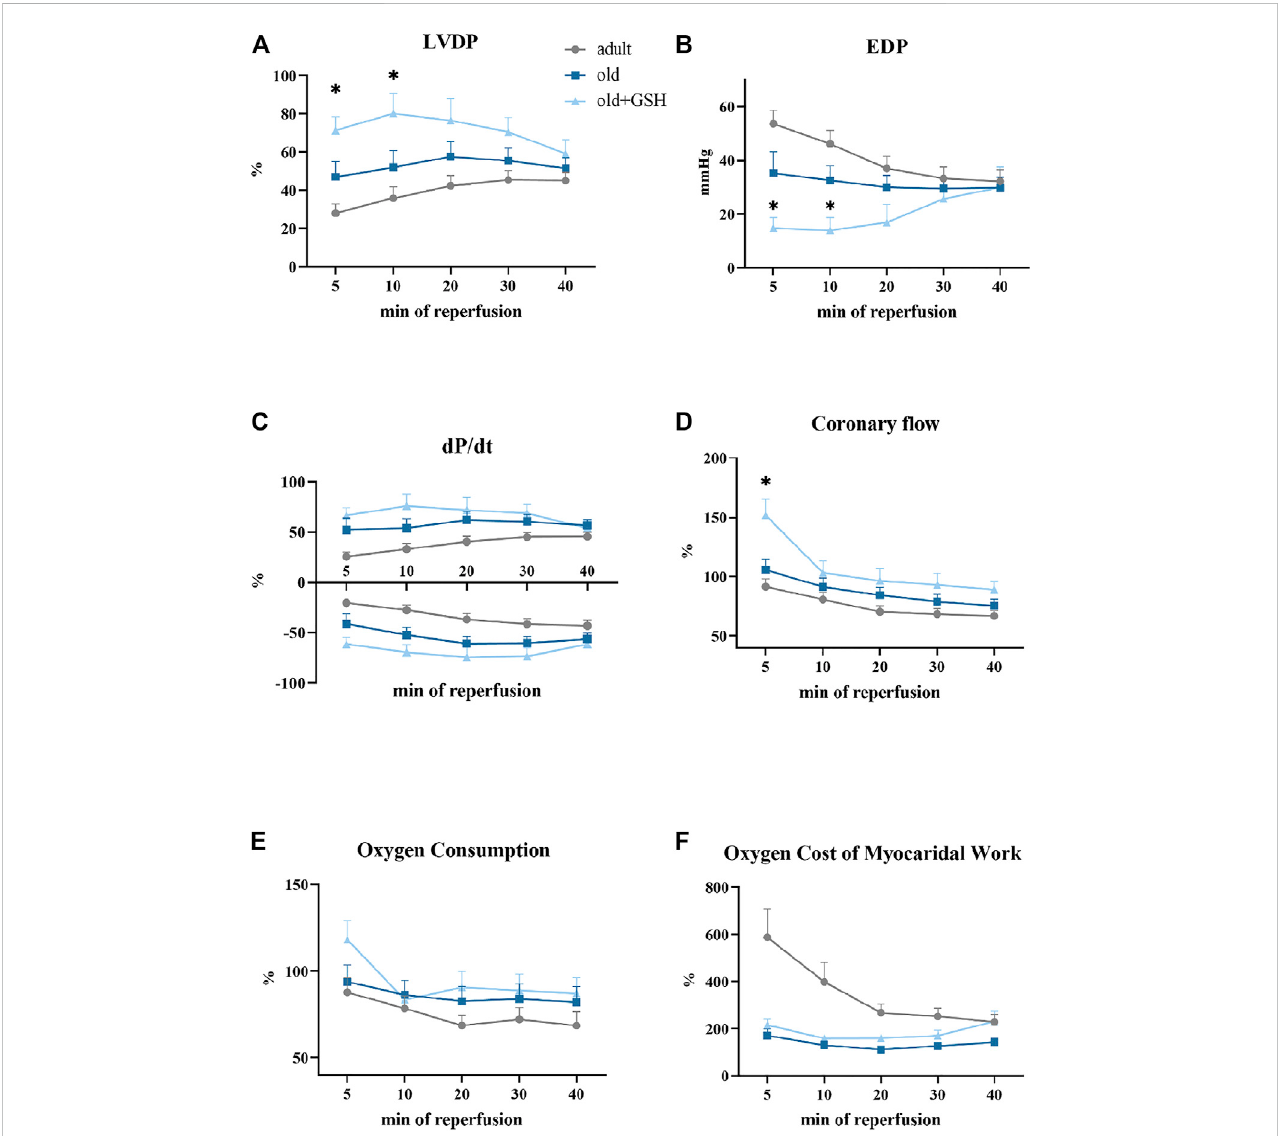
FIGURE 4 Effect of glutathione pretreatment on cardiodynamics restoration of the isolated rat heart after 20 min total ischemia: the left ventricle developed pressure (A) , the end-diastolic pressure (B) , the fi rst derivative of the left ventricle pressure, dP/dt (C) , the coronary fl ow (D) , the oxygen consumption (E) , the oxygen cost of myocardial work (F) . Data are represented as mean ± SEM; n = 12 in the adult, n = 12 in old, n = 6 in old + GSH groups. GSH, glutathione. * p < 0.05 versus old as calculated by Kruskal-Wallis